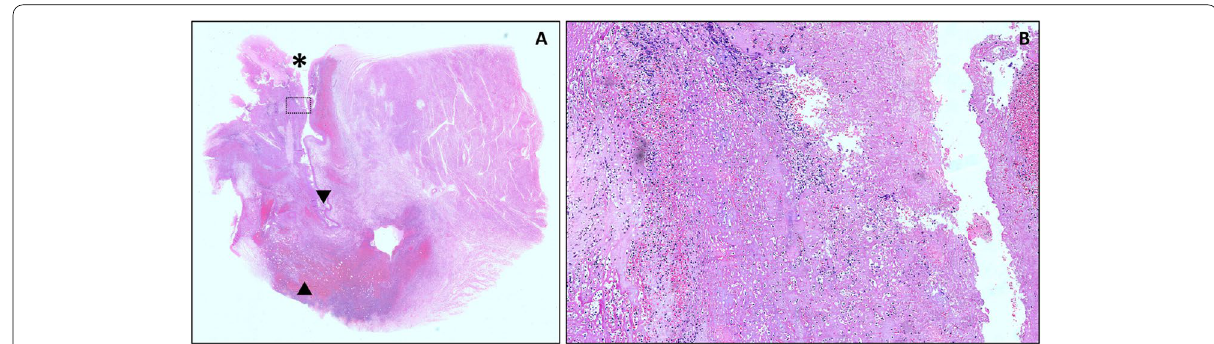
Fig. 2 A and B Section from the cardiac lesion. A Low-power view of the lesion, exhibiting the transmural destruction of the myocardial tissue beneath the valve area (*), replaced by granulating fibrous tissue. There is also a formation of pseudoaneurysm ( ▼ ) with extensive hemorrhage ( ▲ ) that represents the rupture site. A High-power view shows the fibrin vegetation deposits that are seen at the valve and wall of the pseudoaneurysm, extensively infiltrated by